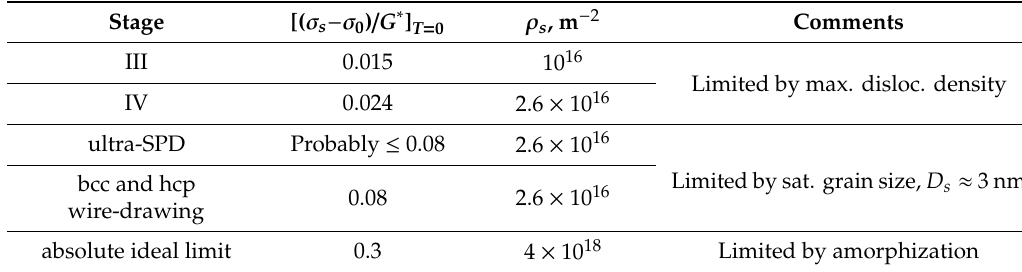
Table 1. Approximate athermal values of the saturation VME flow stress and their